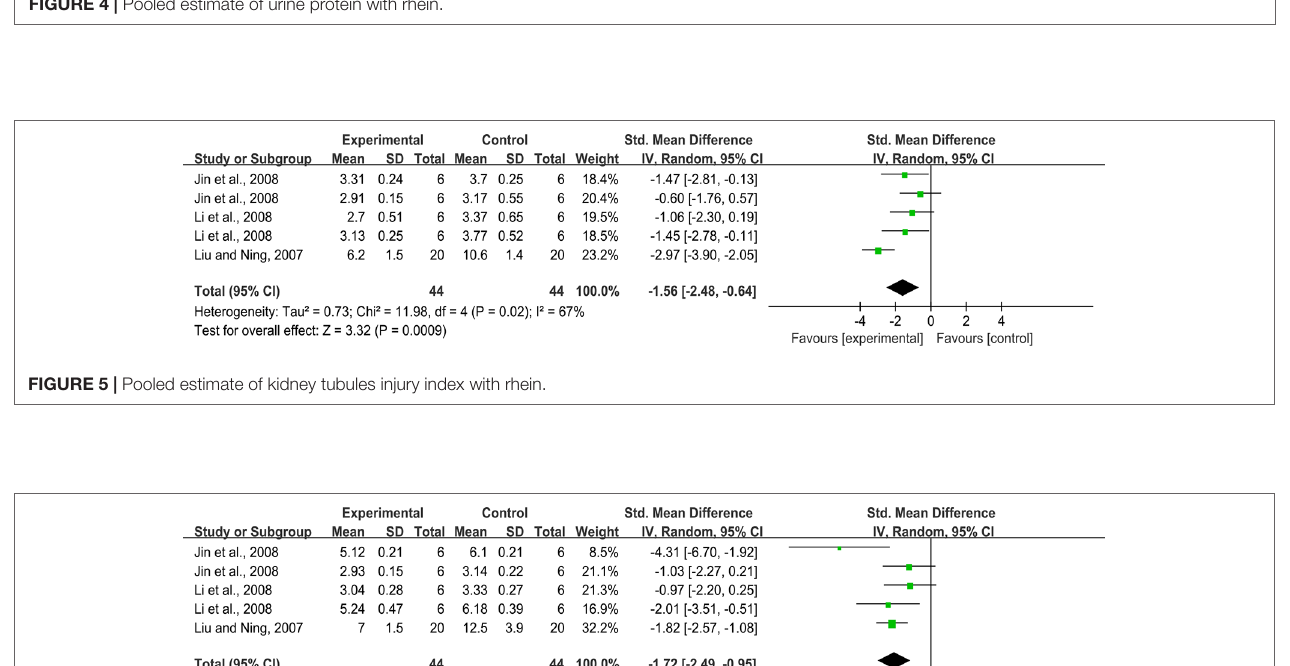
FiGURe 4 | Pooled estimate of urine protein with rhein.